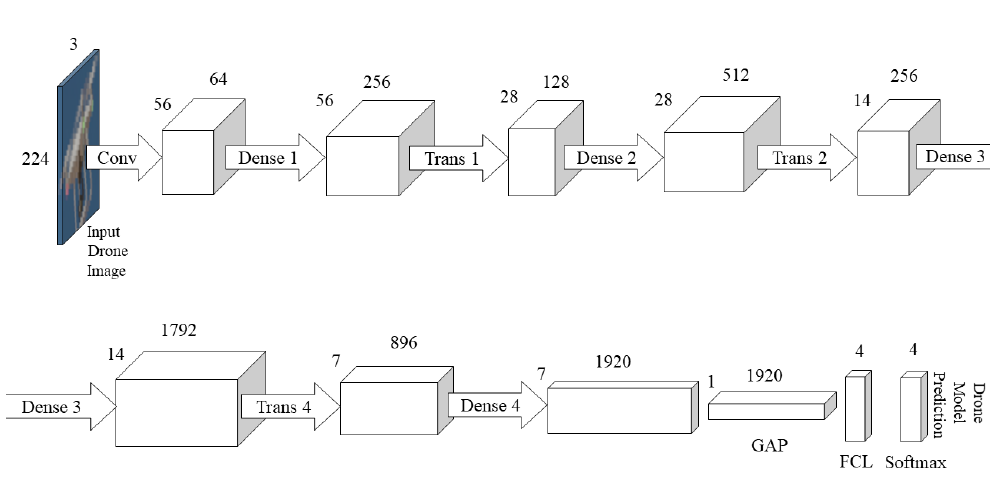
Figure 6. DenseNet201 architecture [48] with the final layer adapted to classify the four classes of DJI Phantom, DJI Mavic, DJI Inspire or no drone. In the graphic, ‘Conv’ refers to a convolutional layer, ‘Dense’ refers to a Dense Block, ‘Trans’ refers to a Transition Layer, ‘GAP’ is the global average pool and ‘FCL’ is the fully connected layer. The input is a 244 × 244 RGB image of a drone, and the output is a prediction of a drone